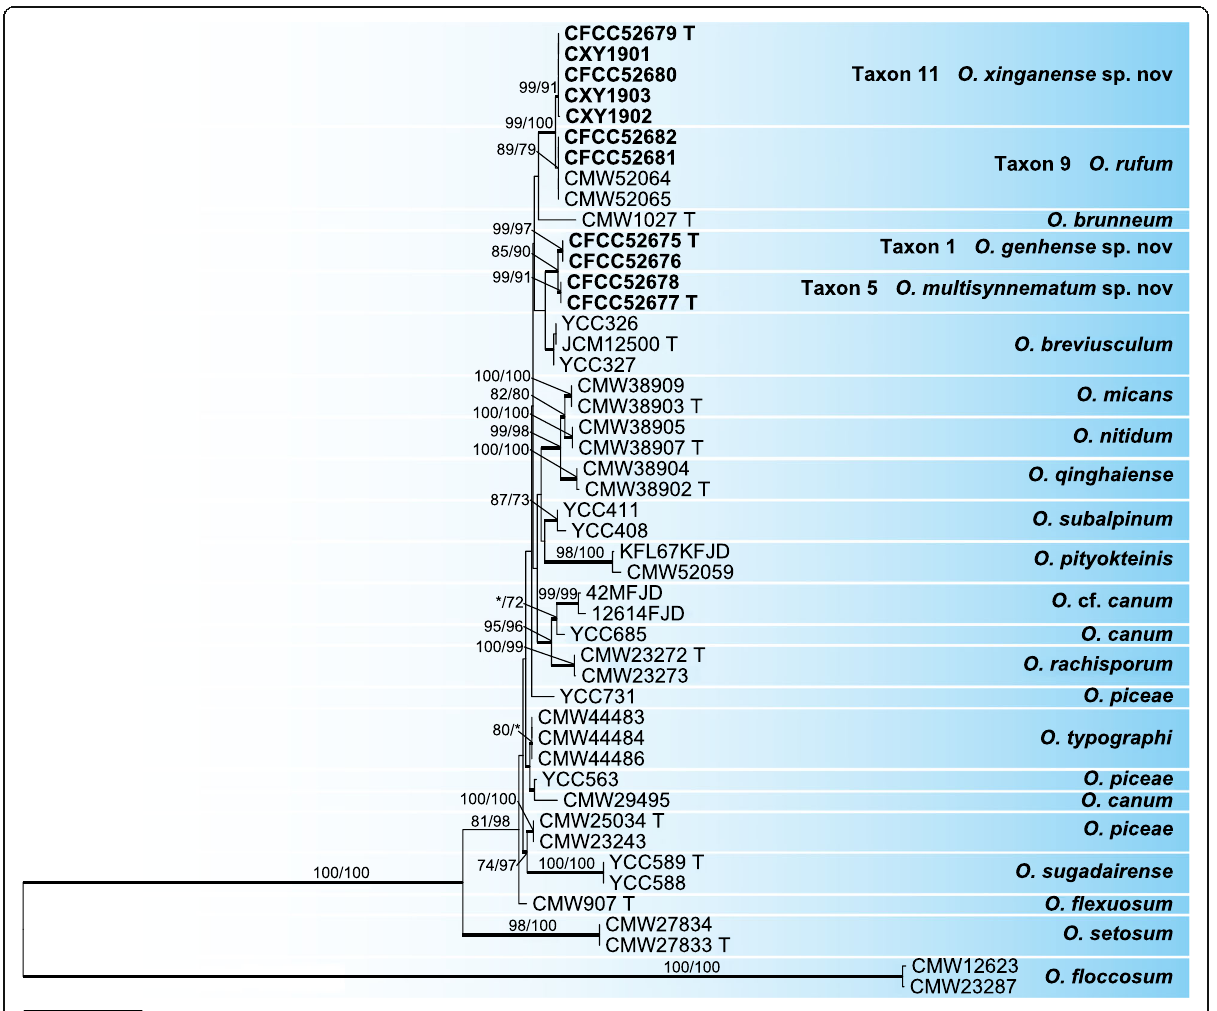
Fig. 3 ML tree of O. piceae complex generated from the combined ( β T+CAL +EF-1 α ) sequence data. Sequences generated from this study are printed in bold. Bold branches indicate posterior probability values ≥ 0.9. Bootstrap values of ML/MP ≥ 70% are recorded at the nodes. T=ex-type